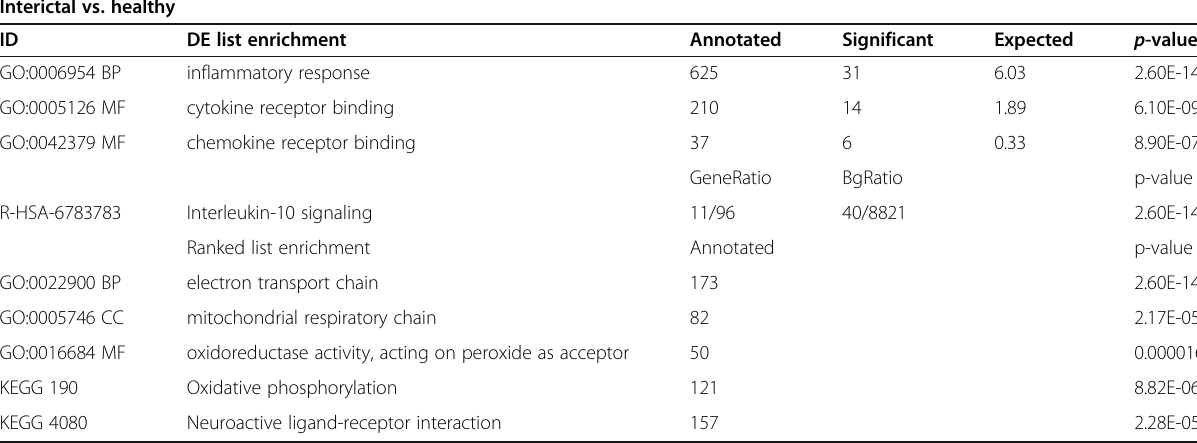
Table 2 Functional enrichment results of PBMC RNA-seq data of the interictal vs. healthy comparison. DE list enrichment: overrepresentation of functional terms in the differentially expressed gene list. Ranked list enrichment: enrichment of genes associated with a certain pathway towards the top of the ranked whole data. GO: gene ontology, BP: biological process, CC: cellular component, MF molecular function. KEGG: Kyoto Encyclopedia of Genes and Genomes. Annotated: number of genes associated with the given term. R: Reactome database. Significant: number of statistically significant associated with the given term. Expected: expected number of genes associated with the given term in the DE gene list. Gene ratio: ratio of number of genes in the DE list that overlap with genes associated with the given term, and the number of genes in the DE list which overlap with genes associated with all terms in the Reactome database. Bg ratio: ratio of the number of genes associated with the given term, and the total number of genes associated with Reactome terms